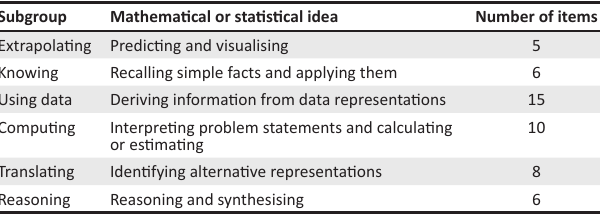
TABLE 9: Classification of the National Benchmark Test quantitative literacy items according to the main competence required.